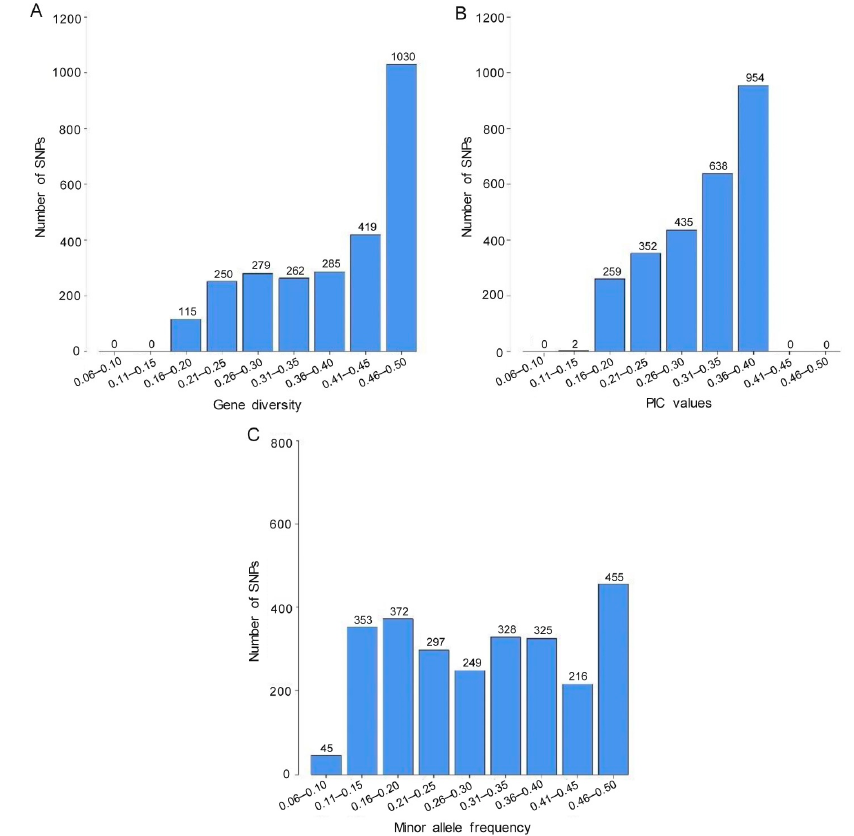
Figure 3. Distribution of ( A ) genetic diversity, ( B ) polymorphism information content (PIC) value, and ( C ) minor allele frequency for 2640 SNPs in 82 R. apiculata accessions.